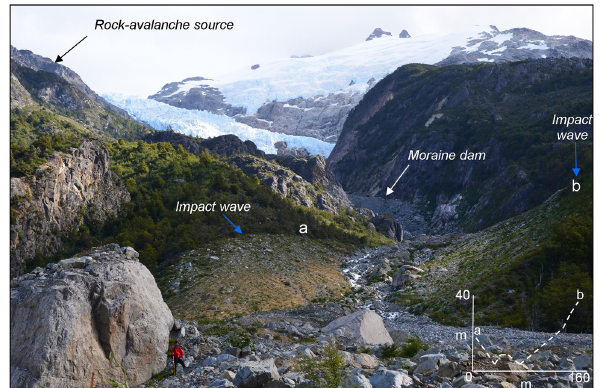
Figure 15. Geomorphic effects of an outburst flood (Los Leones Valley) produced by the impact of a rock avalanche. The small lake, detached from the glacier tongue at the time of failure, was clas- sified with low outburst susceptibility in spite of the steep outlet slope. Note the elevated traces ( ∼ 40m) of the impact wave and the large boulders ( > 6m in diameter) transported by the